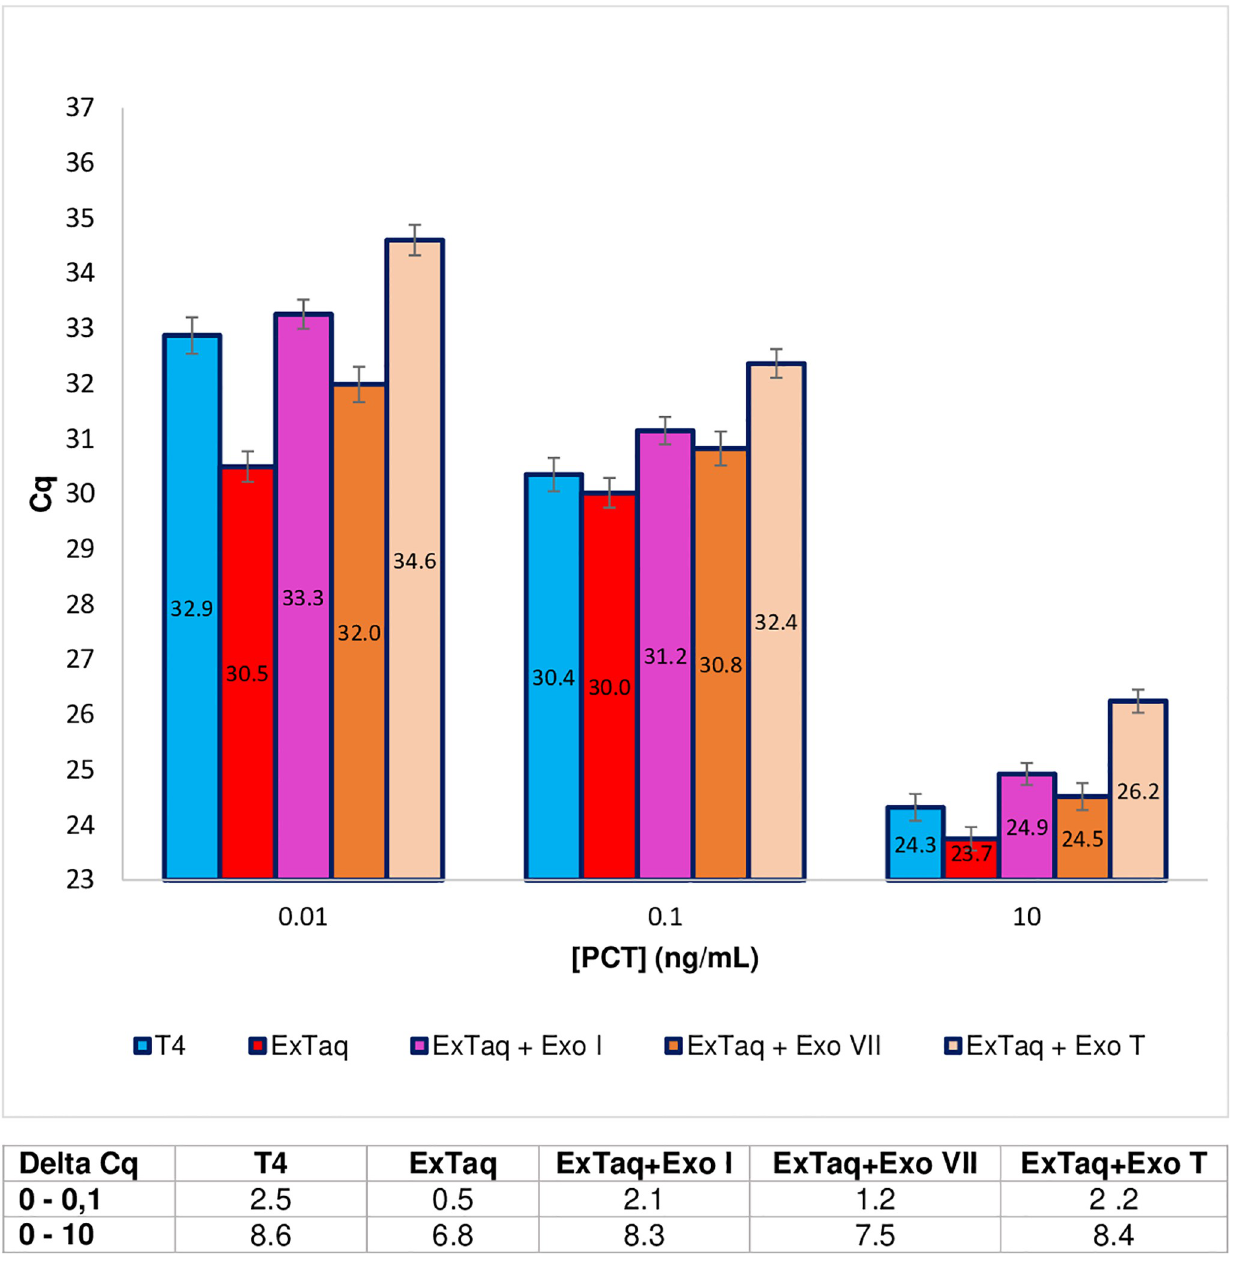
Fig 7. Comparison of different enzymes or enzyme combinations for PEA extension step (short protocol), for three concentrations of rPCT. T4: T4 DNA polymerase; Extaq: Extaq polymerase; Exo I: exonuclease I; Exo VII: exonuclease VII; Exo T: exonuclease T. The results, given in Cq, correspond to the mean of a minimum of three duplicate experiments. The data are also expressed in Delta-Cq (Table below the histograms) corresponding to the difference between the Cq value obtained for 0 ng/mL of rPCT and the Cq value obtained for different concentrations of rPCT.